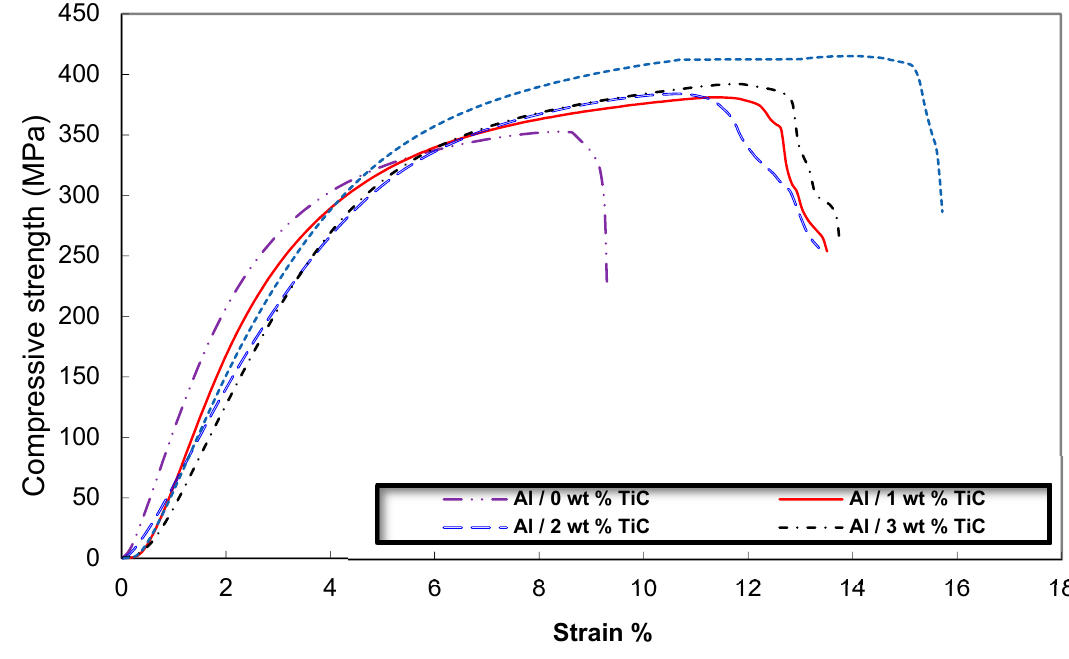
Figure 13. Typical stress-strain diagram of the Al/TiC nanocomposites with different TiC contents.